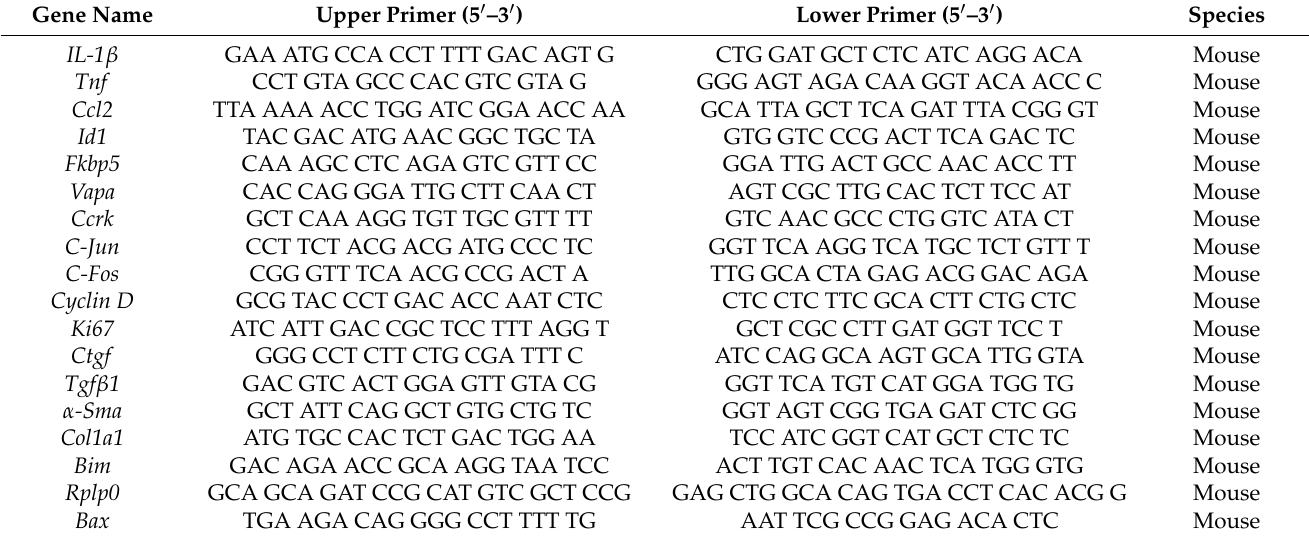
Table 1. Primers used for real-time